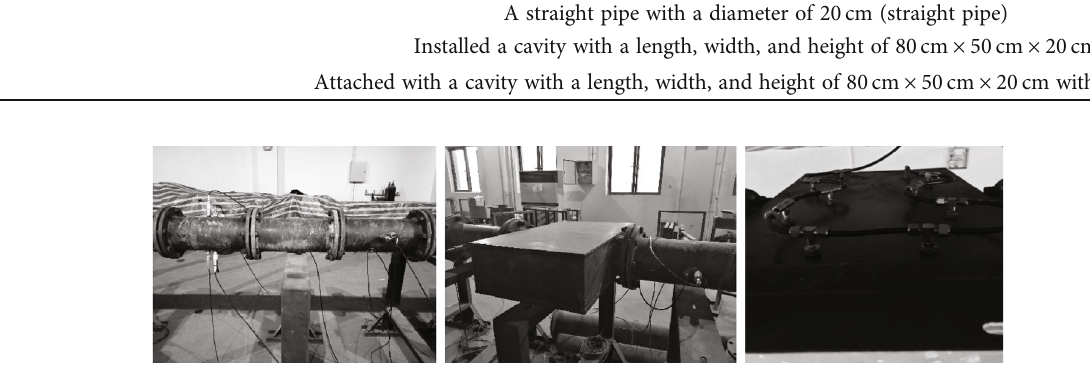
Figure 4: The experiment